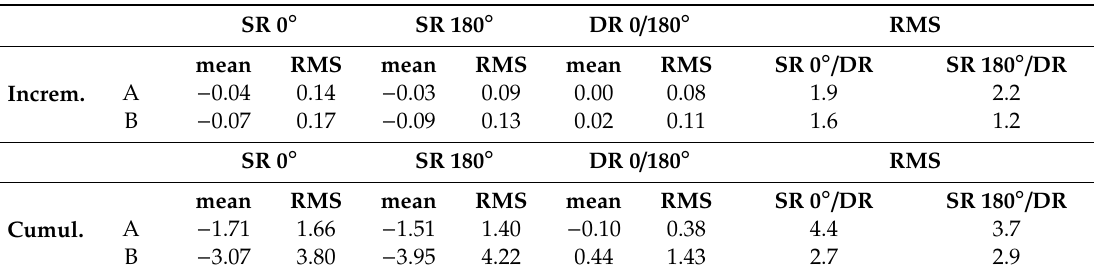
Table 4. Summary of the results obtained in Section 1 (184 measures). In the first part are the incremental displacements and in the second part are the cumulative displacements. SR 0 ◦ SR 180 ◦ DR 0 / 180 ◦ RMS Increm. Cumul.